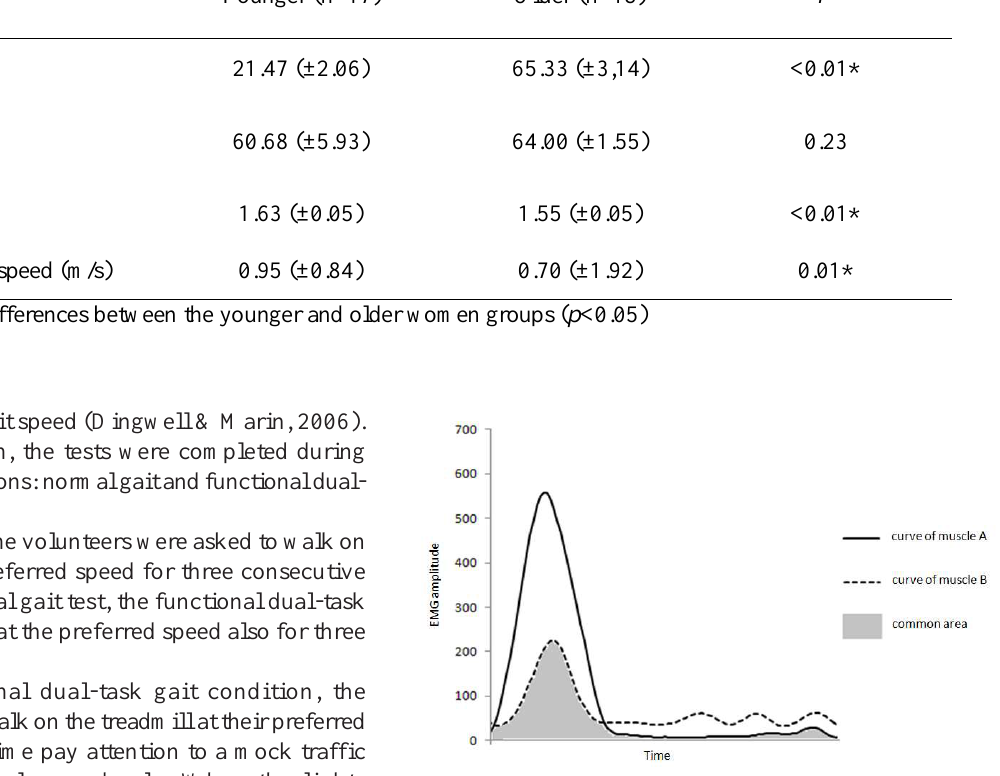
Figura 1. Common area A & B is the common area of activity of muscles A and